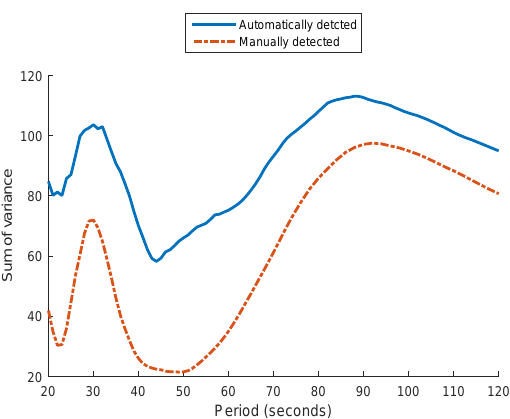
Figure 10: Trend of the minimal sum of variance for TLS.